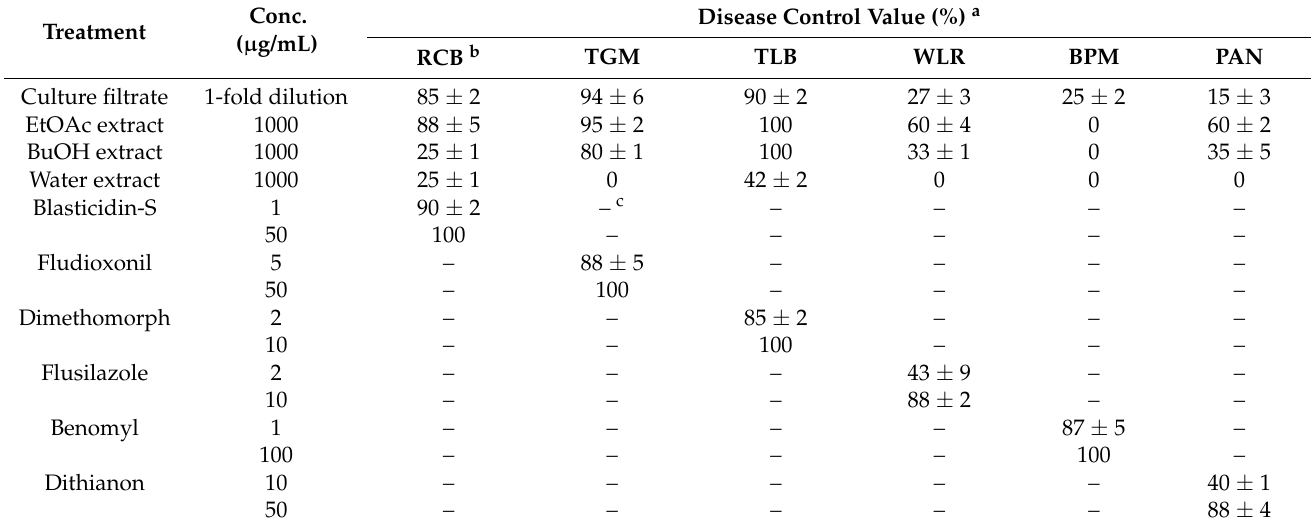
Table 2. Plant disease control efficacy of the SFC100166 culture filtrate and its organic solvent extracts. Conc. Treatment